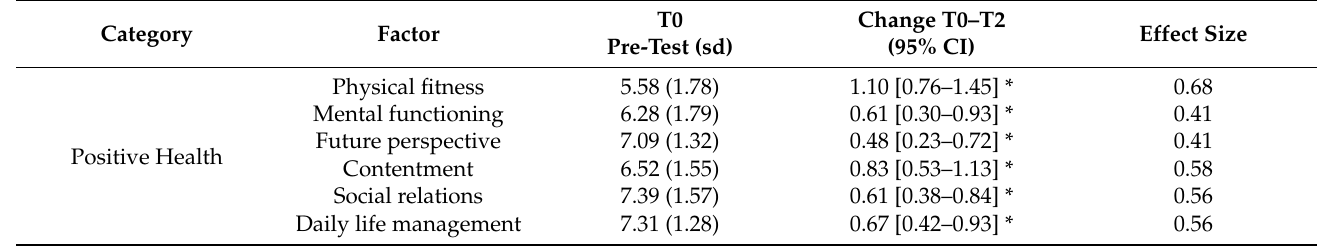
Table 5. Results of the Positive Health